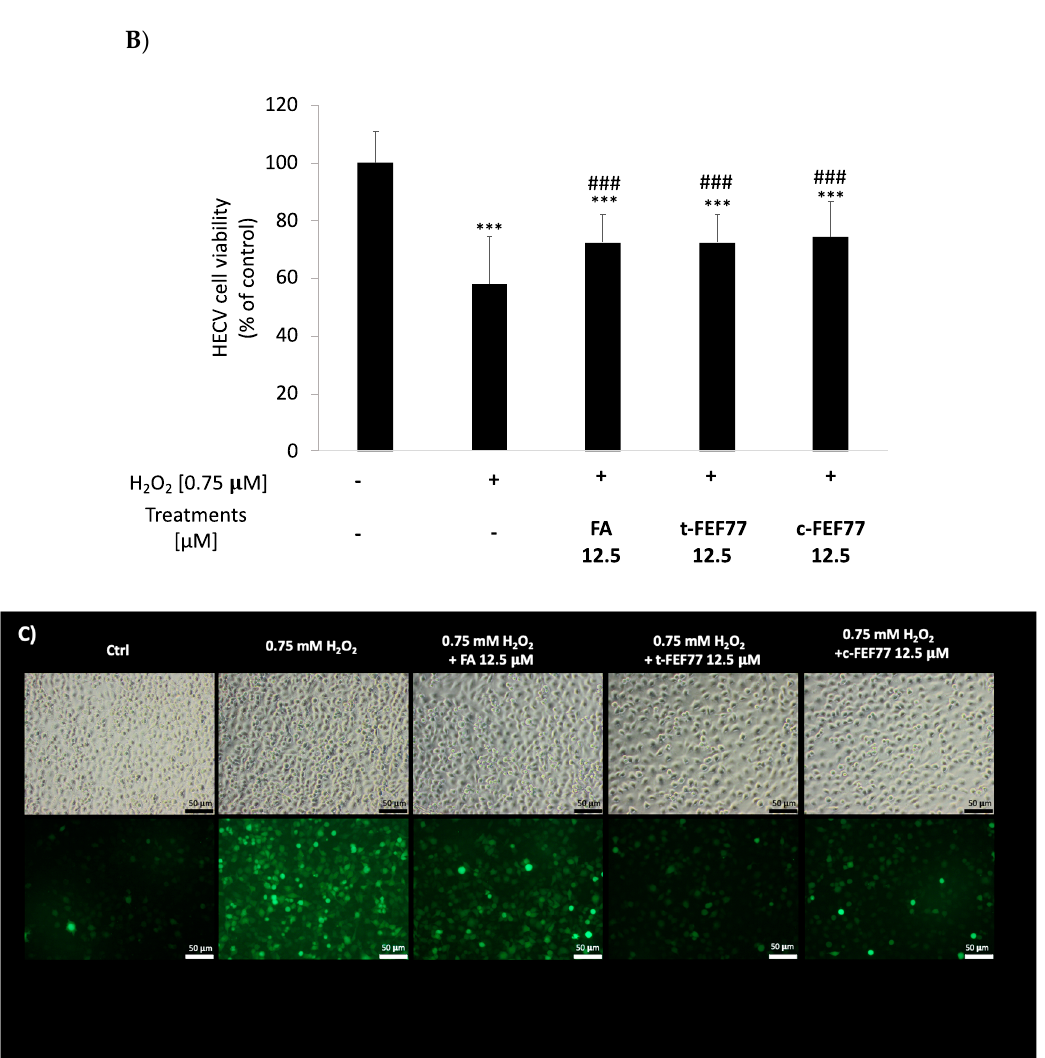
Figure 4. Effects of FA, t-FEF77, and c-FEF77 on oxidative stress in HECV cells. ( a ) HECV cell viability after a 2 h treatment with H 2 O 2 ; ( b ) Viability of HECV cells pretreated with 12.5 μ M polyphenols (FA, t-FEF77, and c-FEF77) for 24 h and subsequently with H 2 O 2 for 2 h. ( c ) Reactive oxygen species (ROS) in HECV cells were underlined by 2 ′ ,7 ′ –dichlorofluorescin diacetate (DCF-DA) stain in the lower panel (upper panel shows the corresponding bright-field; bar: 50 μ m). Data are expressed as percent vs. control (0). Values are mean ± S.D from at least three independent experiments. Significant differences are denoted by symbols on bars (*** p ≤ 0.001 vs control; ### p ≤ 0.001 vs H 2 O 2 ).